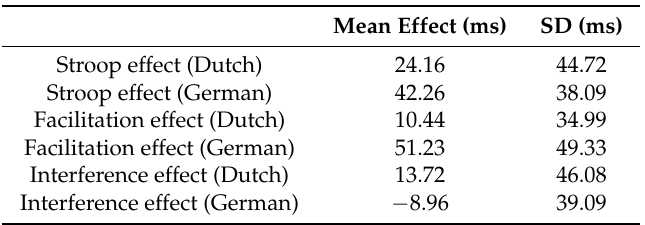
Table 6. Stroop effects of the Dutch-German multilinguals in the Dutch Stroop task and in the German Stroop